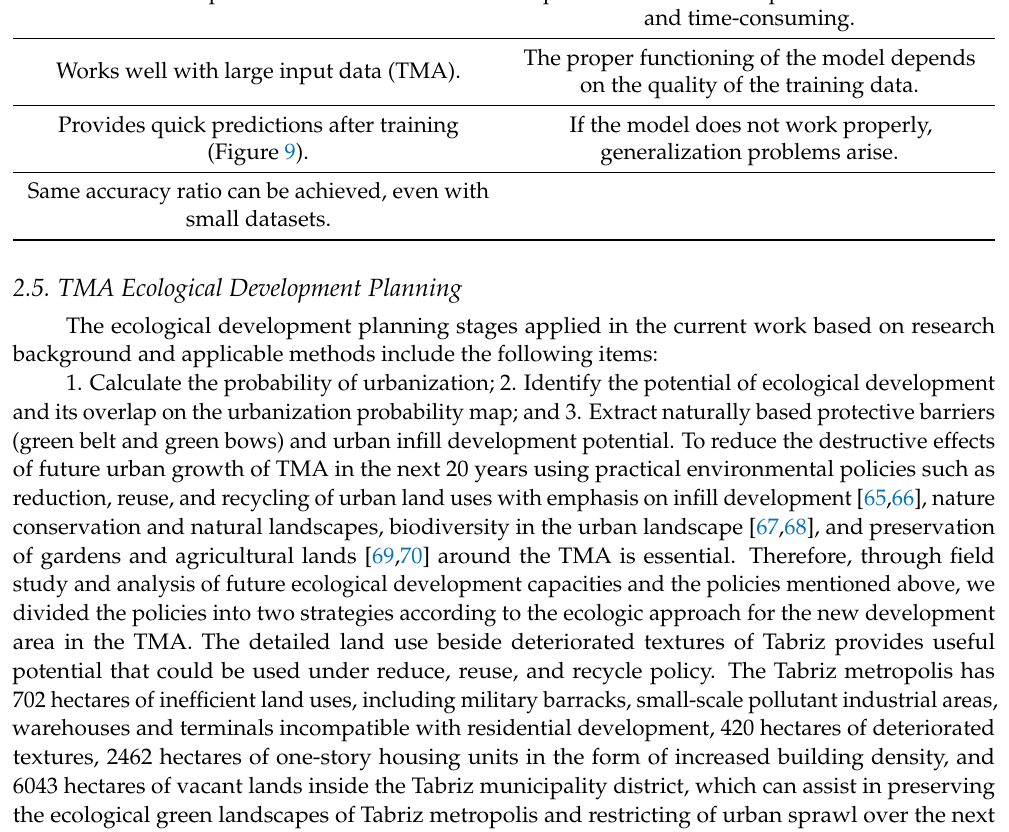
Table 10. ANN-LTM advantages and disadvantages.